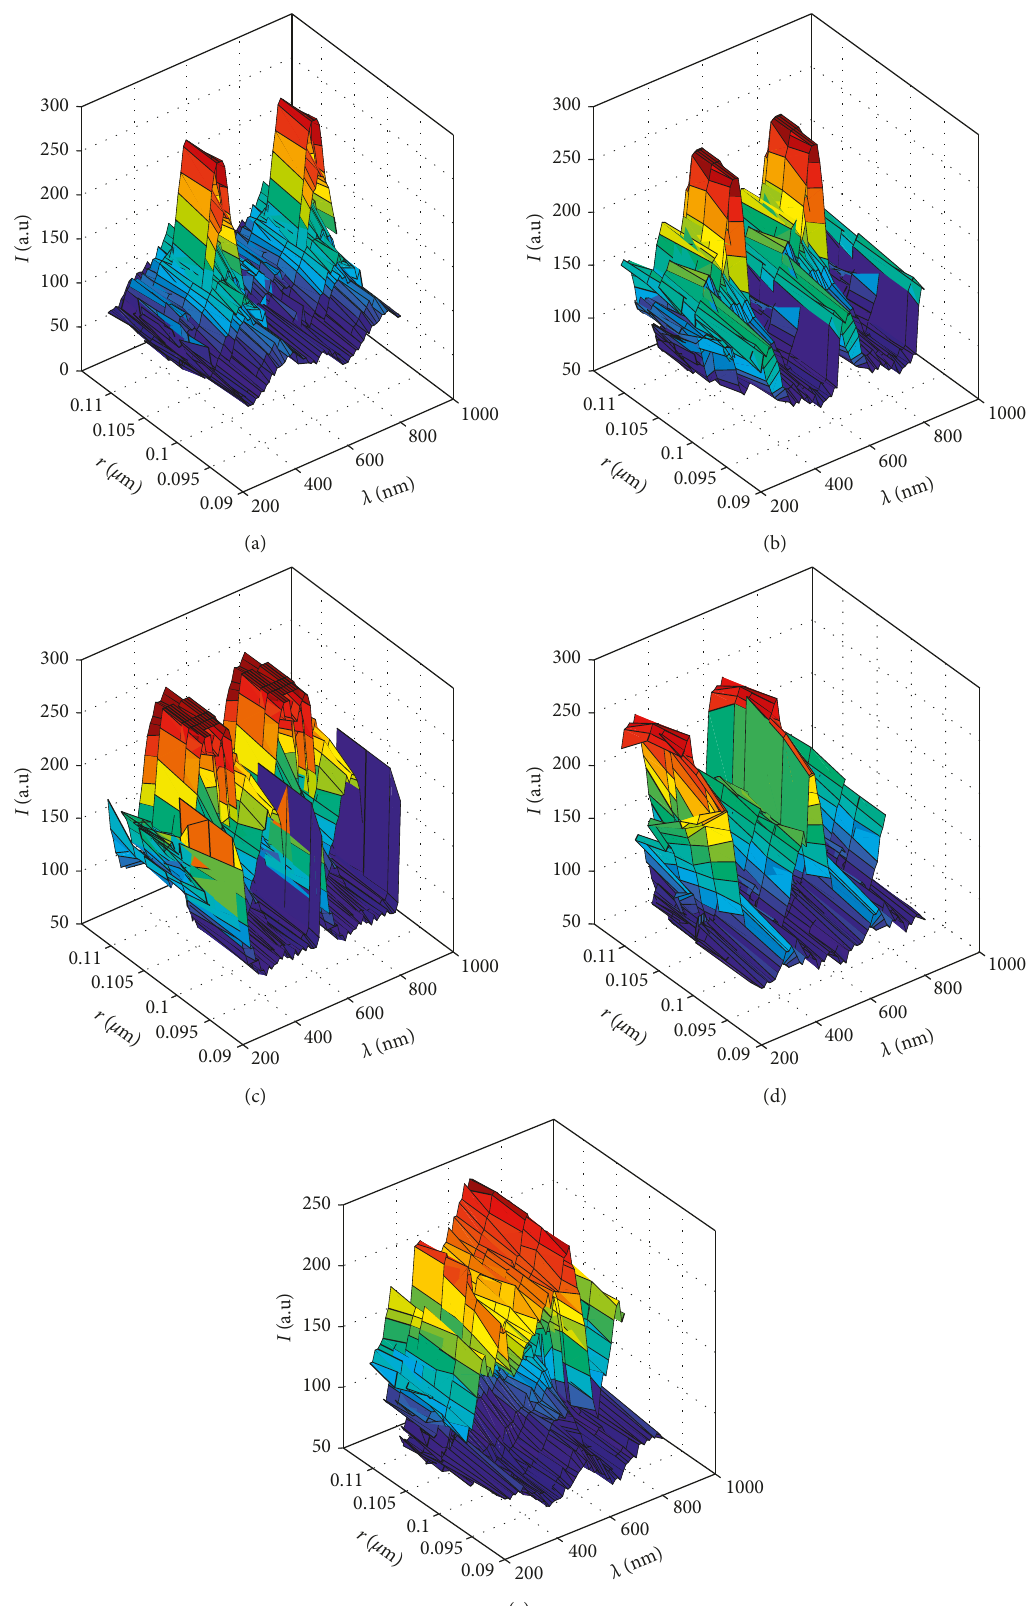
Figure 5: Three-dimensional plots of pixel intensities/a.u (represented as I ) and radii/ μ m (represented as r ) against spectral range/nm (represented as λ ) of multispectral images in the transmission mode for (a) uninfected RBCs ( u -RBCs) and Plasmodium falciparum -infected RBCs ( i -RBCs) of parasite density (PD) (b) (+), (c) (++), (d) (+++), and (e)